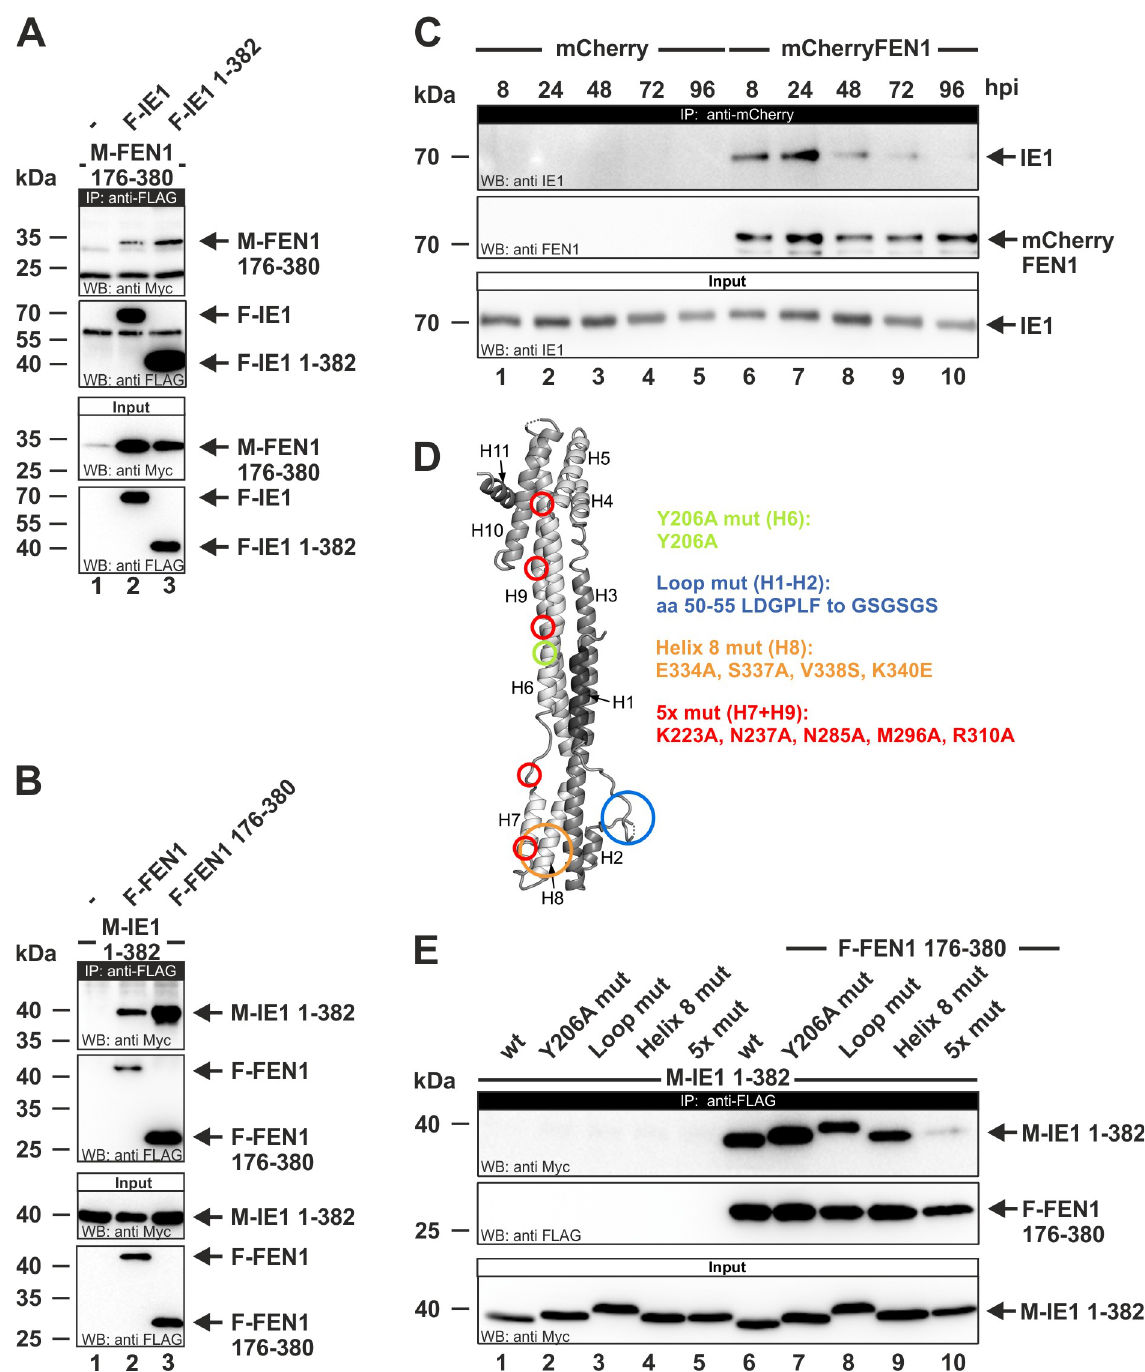
Fig 2. Characterization of the IE1-FEN1 interaction via coimmunoprecipitation (CoIP) experiments. (A, B, and E) HEK293T cells were cotransfected with the indicated Myc (M)- and FLAG (F)-tagged constructs. Upper two panels: Western blot detection of FEN1- and IE1 variants after immunoprecipitation (IP) with an anti-FLAG antibody. Lower panel/panels: detection of FEN1 and IE1 variants in cell lysates before precipitation (input). (A) IP of F-IE1 and F-IE1 1–382, CoIP of M-FEN1 176–380. (B) IP of F-FEN1 and F-FEN1 176–380, CoIP of M-IE1 1–382. (E) IP of F-FEN1 176–380, CoIP of different wildtype (wt) and mutant versions of M-IE1 1–382. (C) HFFs stably expressing mCherry or mCherryFEN1 were infected with AD169 at an MOI of 3 and lysed at the indicated times post infection. Upper two panels: Western blot detection of mCherryFEN1 and IE1 after immunoprecipitation (IP) with an anti-mCherry antibody. Lower panel: detection of IE1 in cells lysates before precipitation (input). (D) Schematic of the IE1 core structure. Regions that were mutated in order to generate Y206A, Loop mut, Helix 8 mut, and 5x mut are depicted in green, blue, orange, and red, respectively.